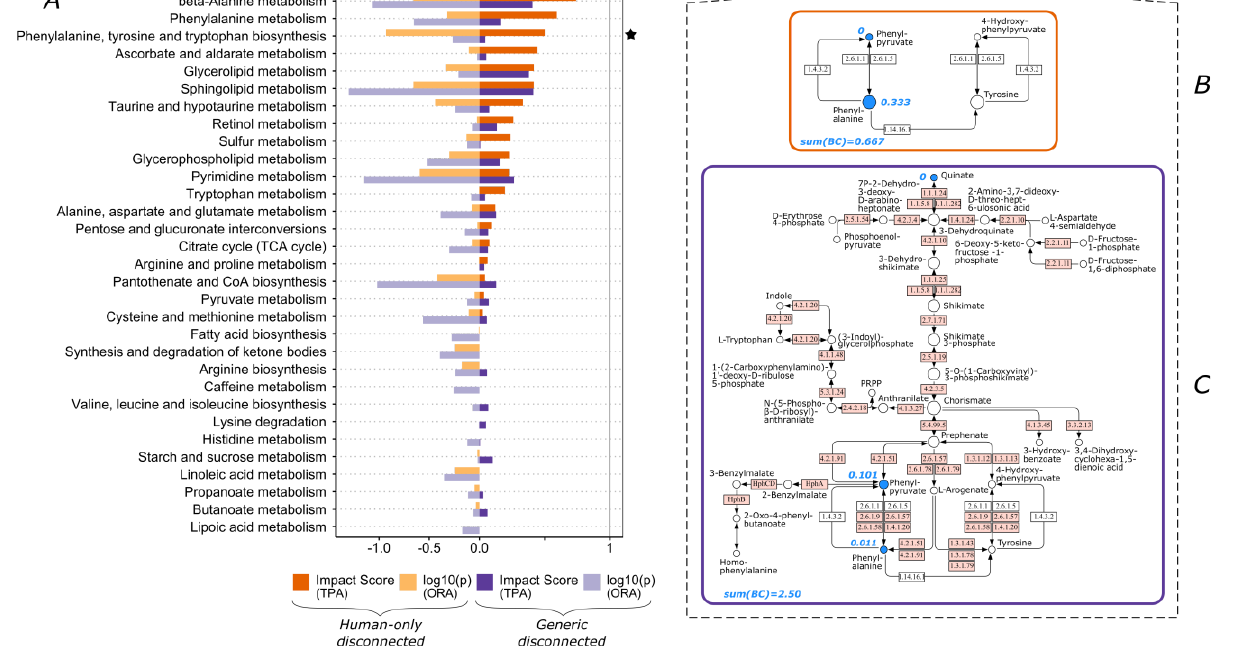
Figure 2. Pathway scoring comparison for dataset 1b. ( A ) TPA impact scores and ORA log10(p) values for all pathways (pathways exhibiting zero values in all cases are omitted). ★ “Phenylalanine, tyrosine and tryptophan biosynthesis” pathway for ( B ) human-only disconnected and ( C ) generic disconnected. Blue color denotes significant compounds in this dataset, blue values are the computed betweenness centrality scores for these nodes, sum(BC) is the sum of betweenness centrality scores for all the nodes of the pathway, and node size corresponds to the relevant betweenness centrality scores of the nodes within the pathway. White and pink boxes denote human native and non-human native enzymatic reactions, respectively.